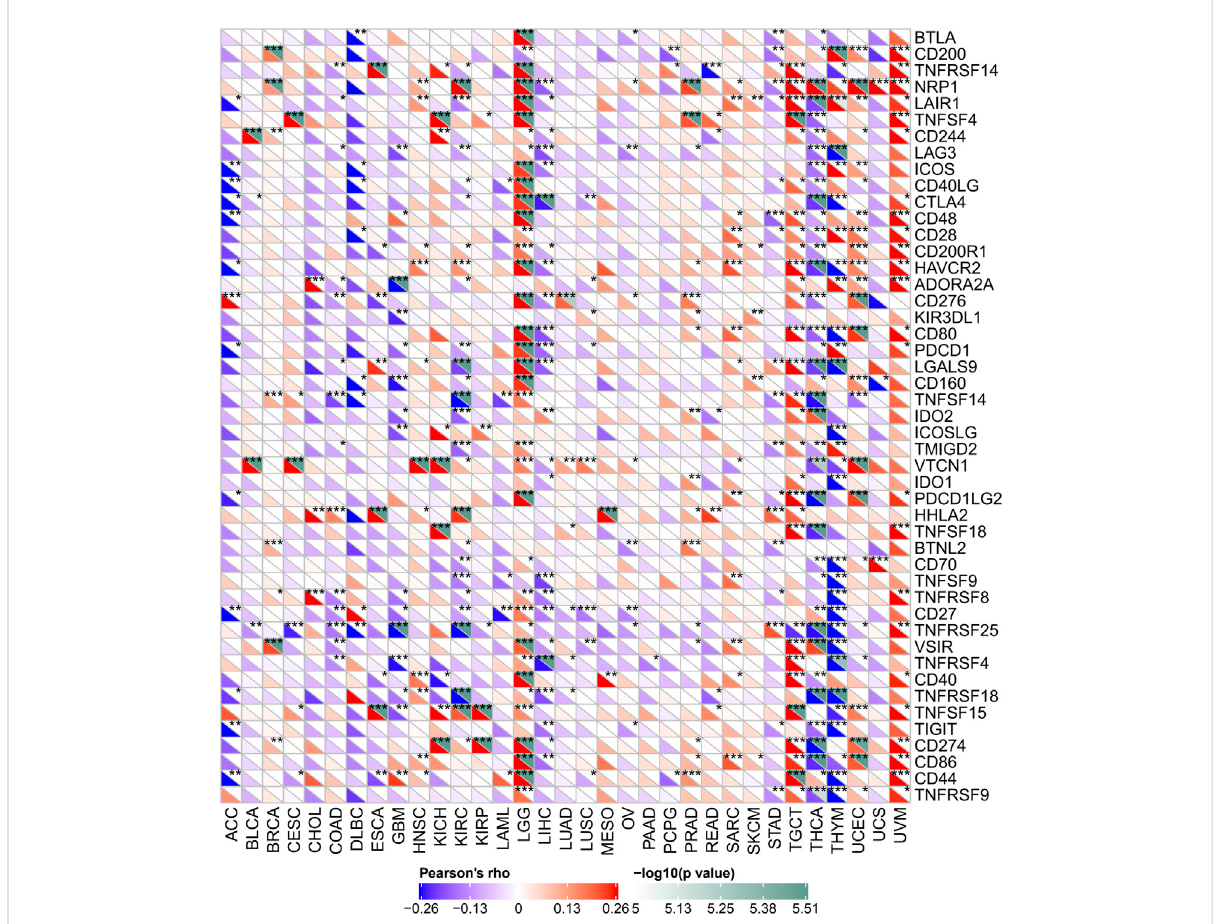
FIGURE 8 Relation between FDX1 mRNA expression levels and mRNA expression at recognized immune checkpoints in multiple tumors from theCancer Genome Atlas database. The lower triangle refers to the coef fi cients calculated by Pearson ’ s correlation test, and the upper triangle represents the p -value converted by log10. * p < 0.05, ** p < 0.01, *** p <